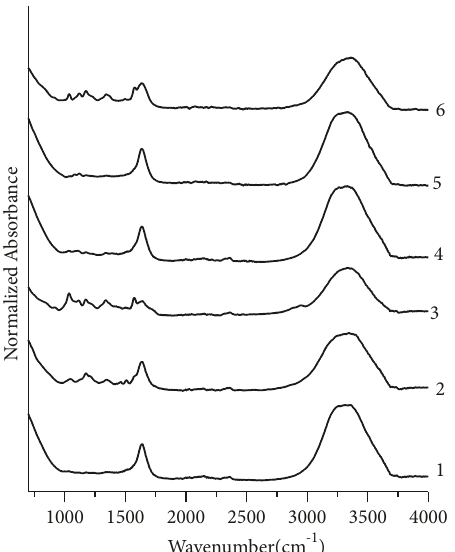
Figure 8: Normalized FTIR absorption spectra for green fountain pen inks. 1, 2, 3, and 4 represent samples no. GN1, GN2, GN3, and GN4, respectively.